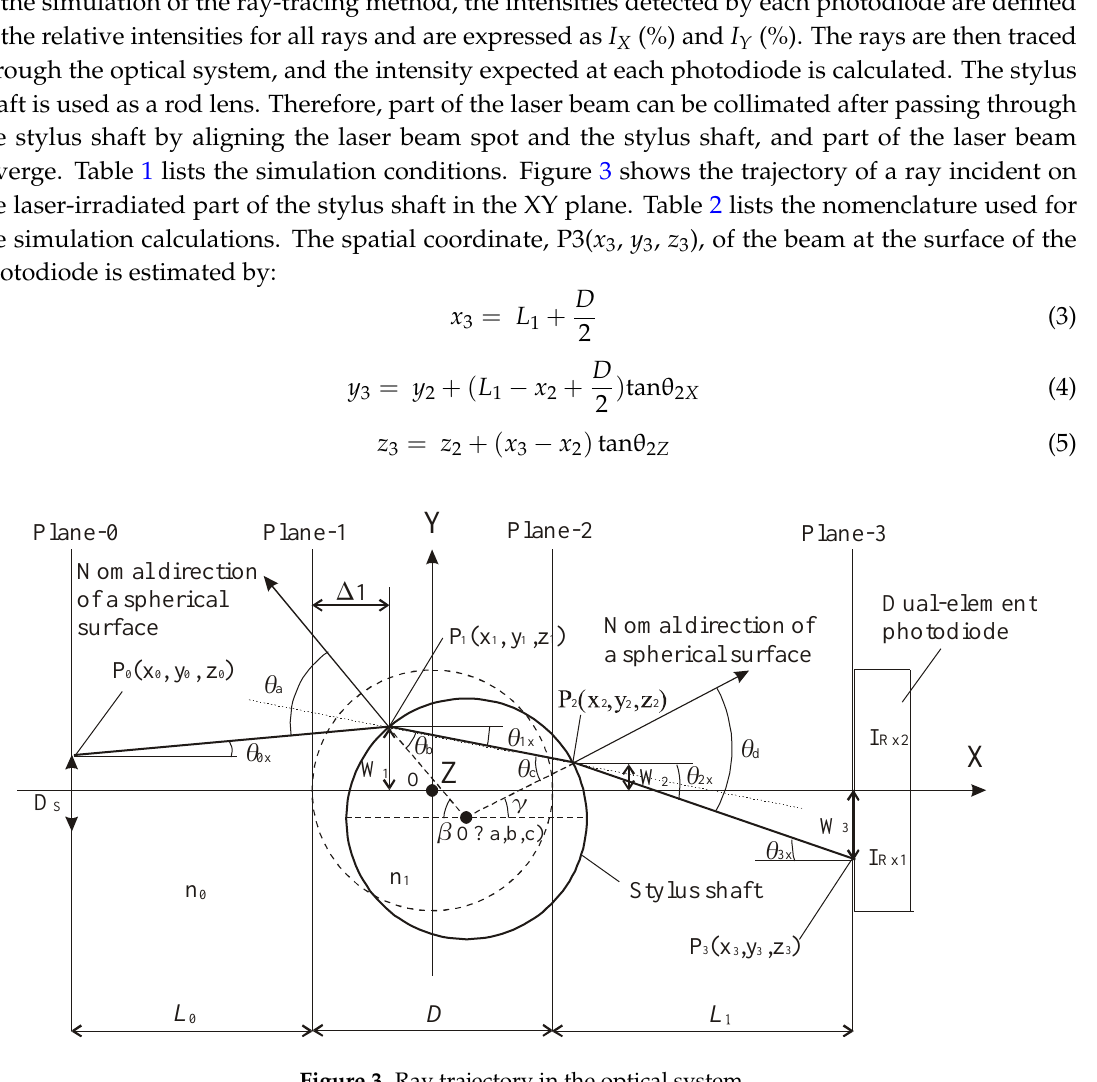
Figure 3. Ray trajectory in the optical system. Table 2. Nomenclature used for simulation calculations.